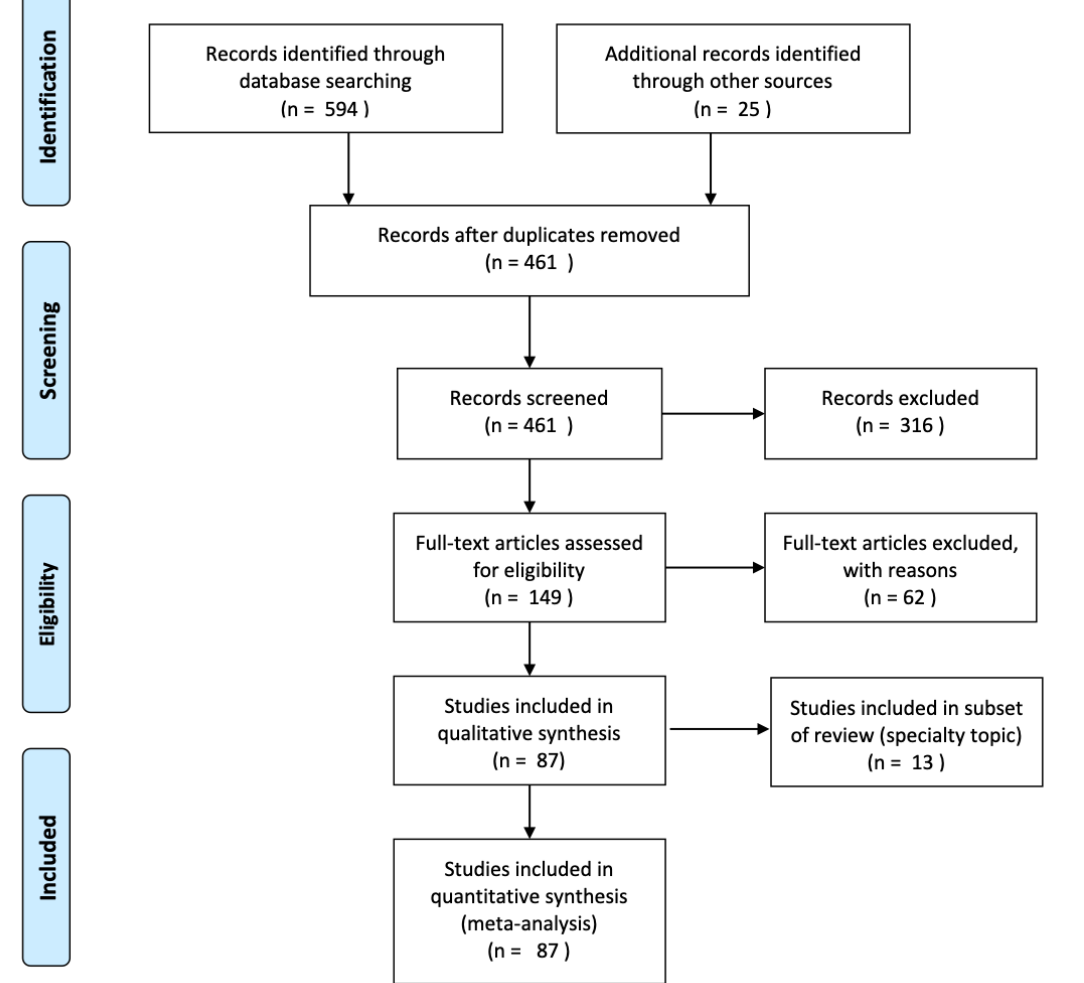
Figure1. Figure 1. Preferred Reporting Items for Systematic Reviews and Meta-Analyses (PRISMA) flow diagram.